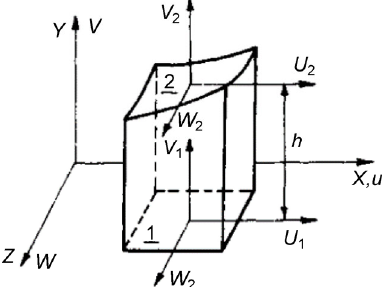
Fig. 1 Wedge-film